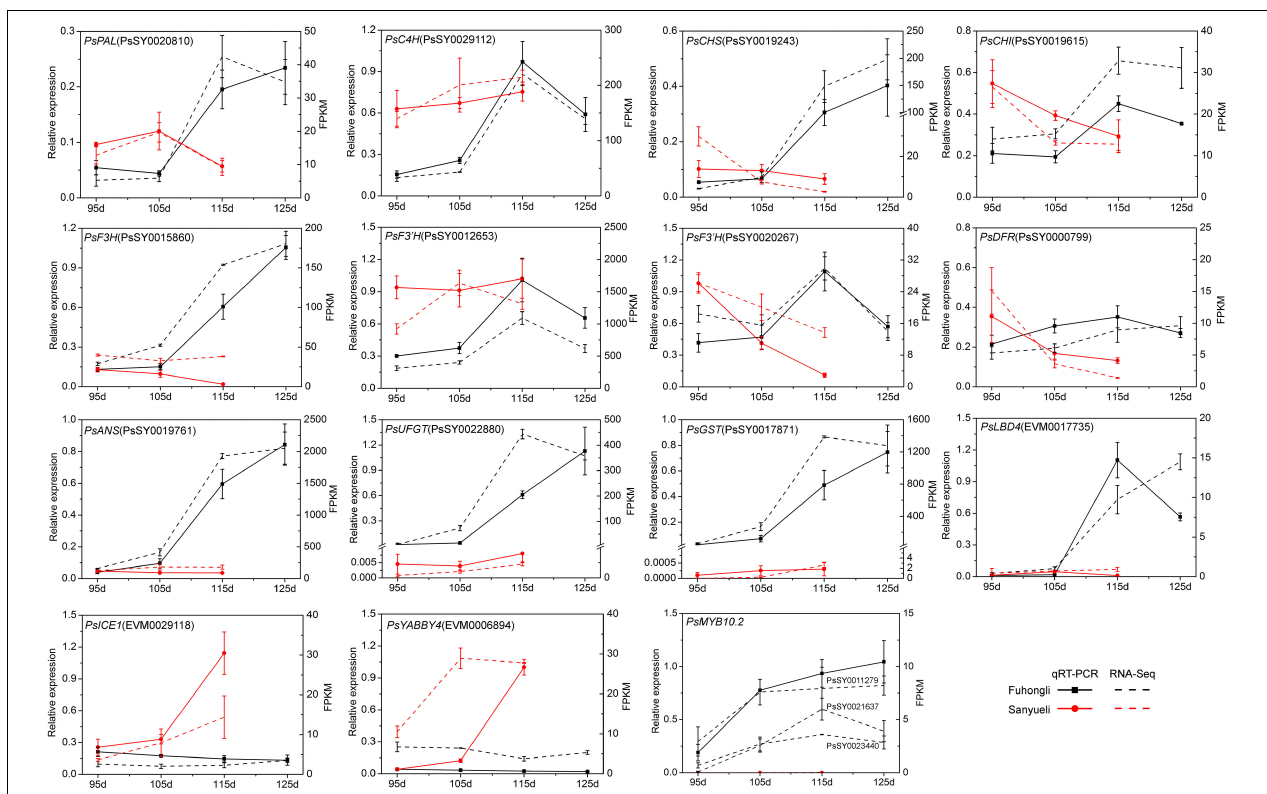
FIGURE 4 | Expression profiles of selected differentially expressed transcription factors in the flesh of ‘Sanyueli’ and ‘Fuhongli’. FPKM values of all genes were normalized with maximum FPKM values of each gene. The expression level of genes was indicated using filled circle with different size and color. The larger the circle, the higher the expression. The values on the right indicates the highest FPKM value of each